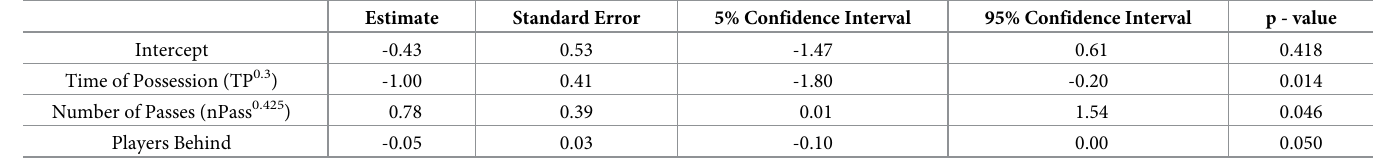
Table 7. Random effect estimated log odds intercepts and base probabilities for shots from possessions that originate in the defensive zone that result in a goal for each team at the 2010, 2014 and 2018 World Cup